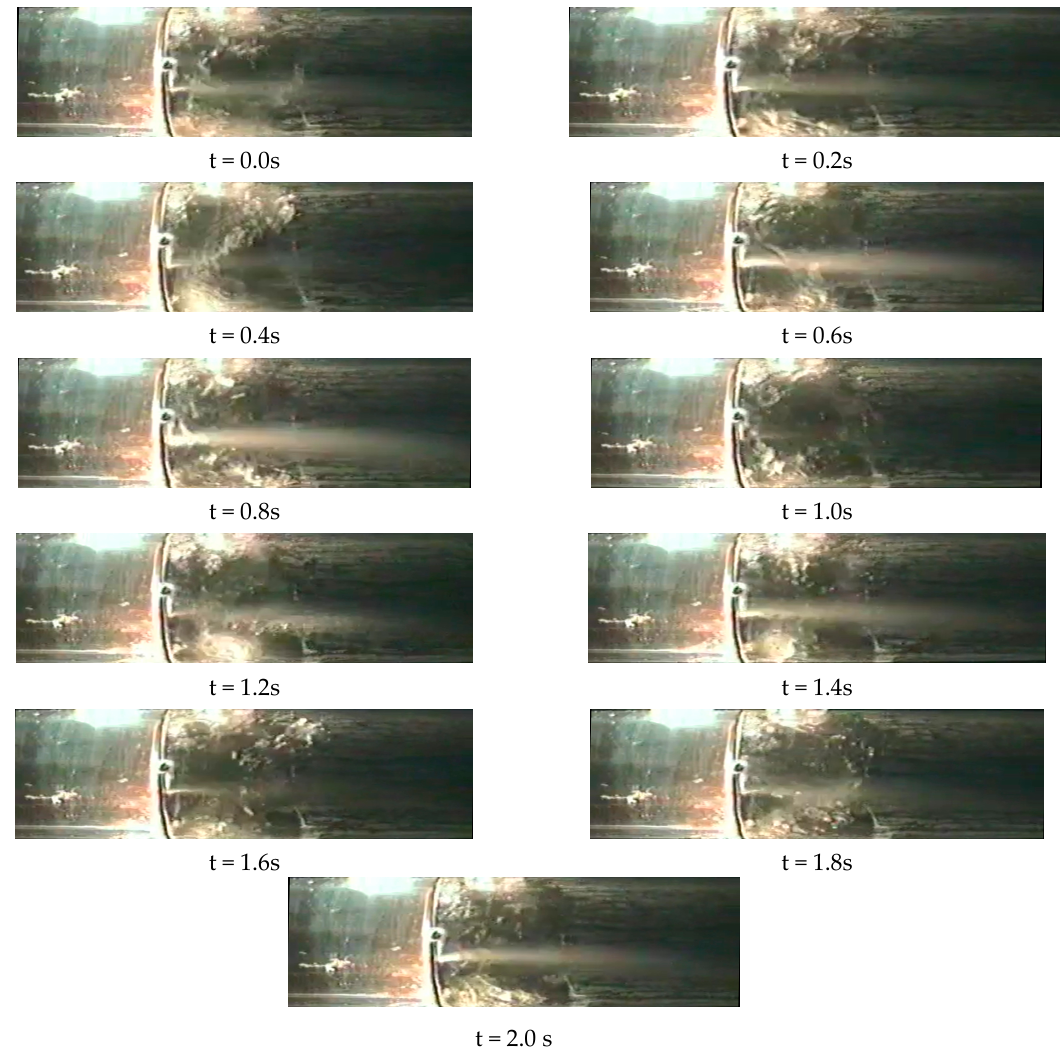
Figure 6. Successive images of wet gas flow through a standard orifice [23].